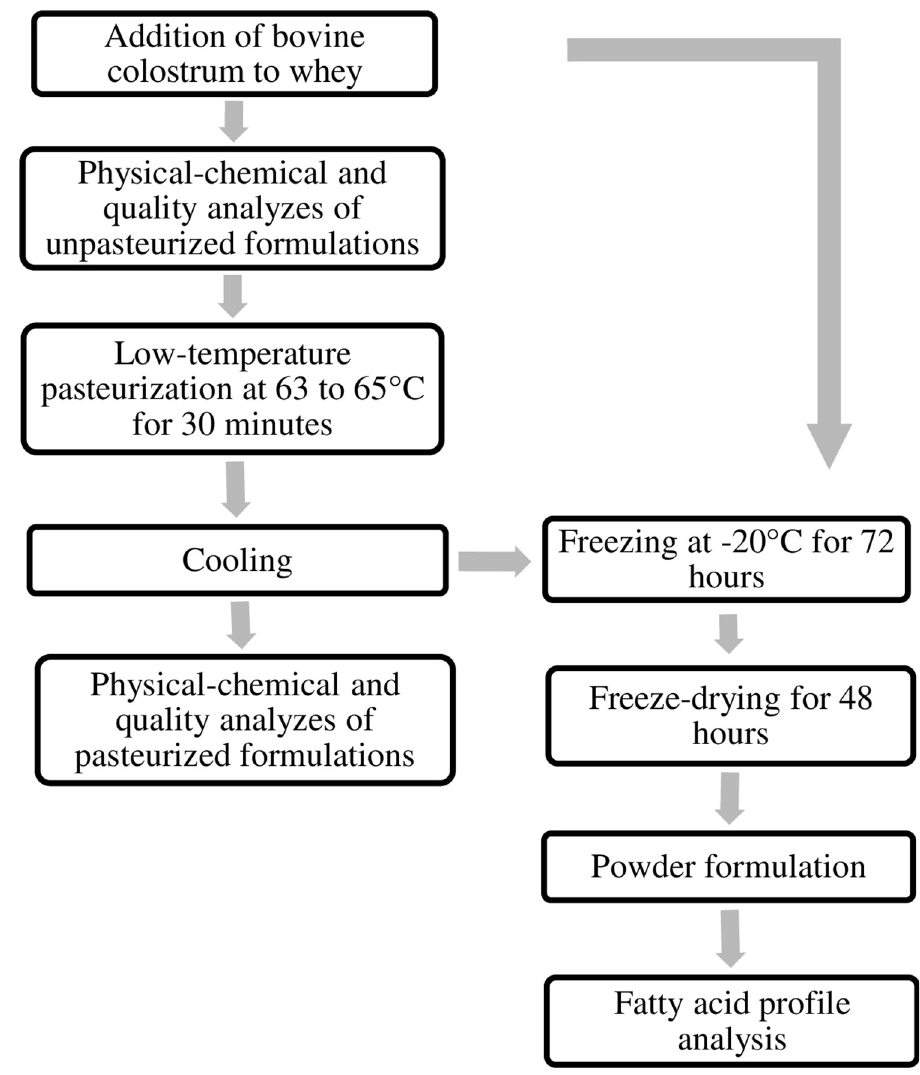
Fig 1. Processing flowchart for the production and pasteurization of formulations and freeze-drying of pasteurized and unpasteurized samples for fatty acid profile